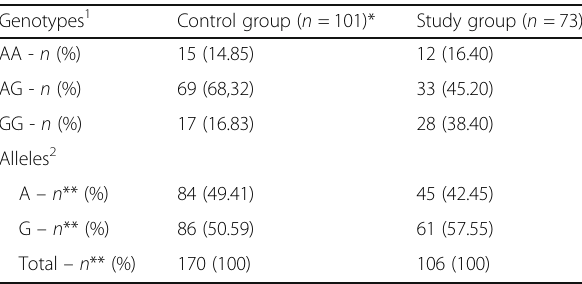
Table 3 Frequency distribution of the genotypes and Alleles of the Xba I polymorphism in patients with precocious puberty and normal puberty